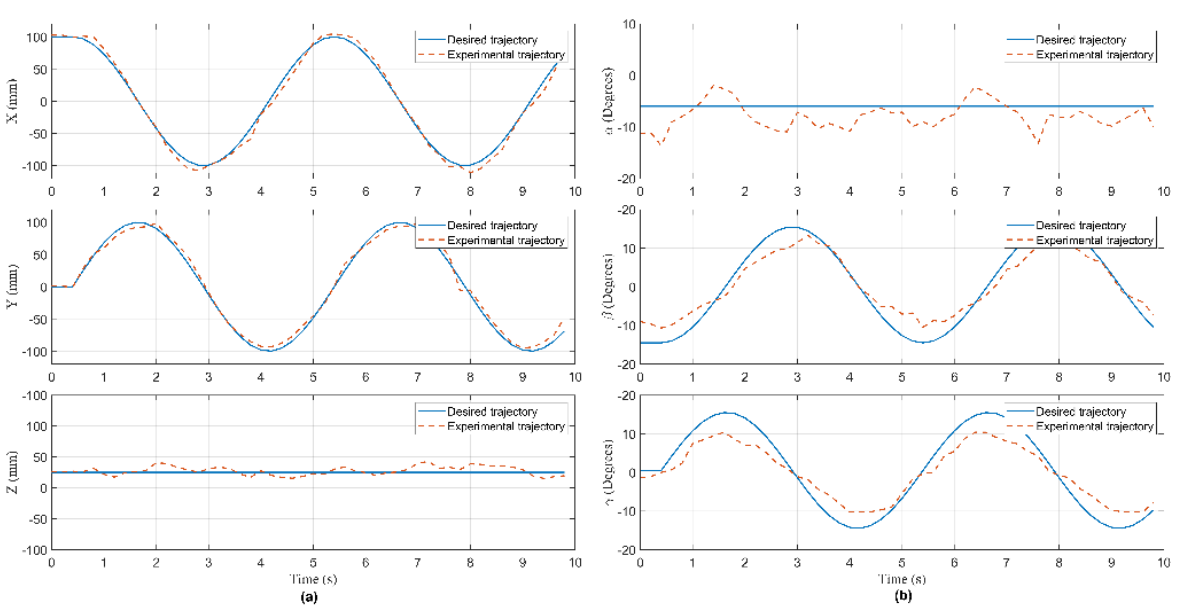
Figure 9. The pose of the end-effector in Case 1: ( a ) The position of the end- effector; ( b ) the orientation of the active plate.